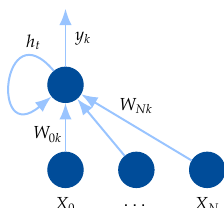
Figure 6. A simple recurrent neural network. See text for